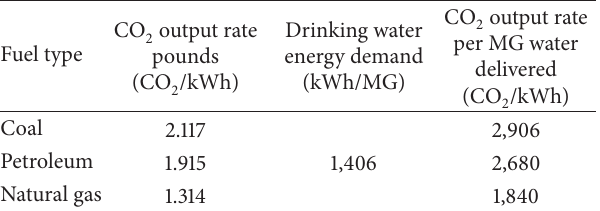
Table 2: Carbon dioxide emission from water treatment and distribution system